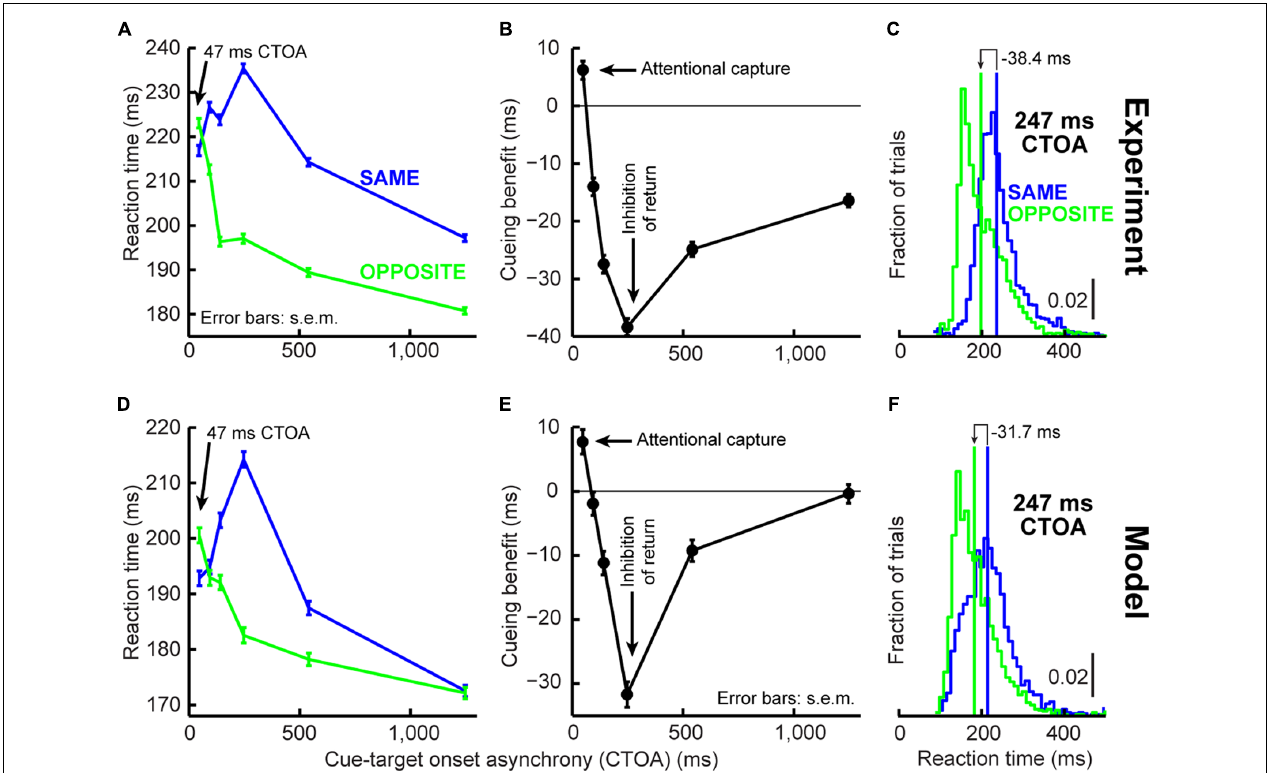
FIGURE 3 | Orienting dynamics in experiment and model. (A) Saccade reaction time (RT) in the cueing task of Figure 2A as a function of CTOA for “same” and “opposite” trials. RT was faster for “same” at 47 ms CTOA but slower later. (B) Cueing benefit defined as the RT difference between “opposite” and “same,” highlighting the benefits and costs in (A) . (C) RT distribution for the CTOA with maximal IOR. “Opposite” was faster on average but had similar variability range as “same.” Please also see Figure 4B (top) and Supplementary Figure S1 for RT distributions from all other CTOA’s. (D–F) Model results capturing the dynamics of the experimental data in (A–C) . Subsequent figures also show individual subject results and model simulations with reduced trial numbers. All error bars denote SEM. Each data point has N ∼ 2,000–3,000